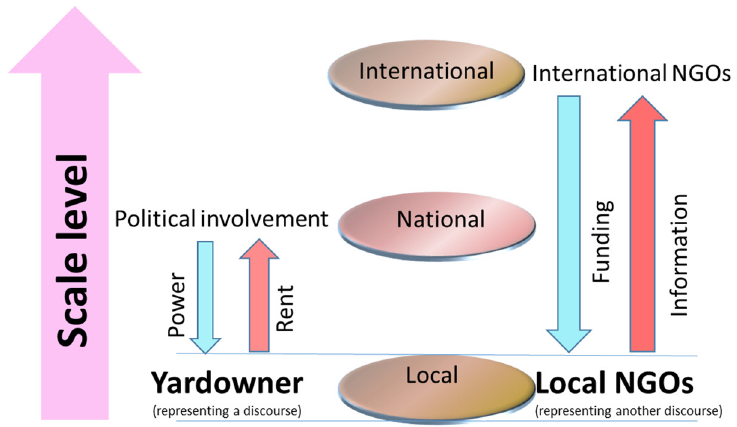
Figure 3. Yard owner and local NGOs scale association in Bangladesh shipbreaking industry.